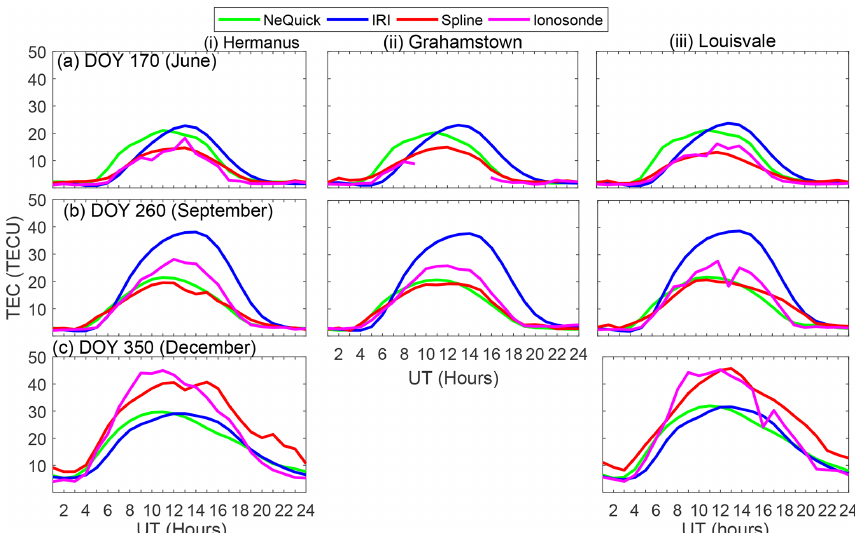
Figure 6. Magenta color shows diurnal TEC observed by ionosonde stations at Hermanus (panels in column i), Grahamstown (Panels in column ii), and Louisvale (Panels in column iii). The green, blue, and red colors show TEC estimations using NeQuick 2, IRI-2016, and spline models, respectively. Panels in rows (a–c) show diurnal TEC during the year 2013 on DOY 170, 260, and 350,